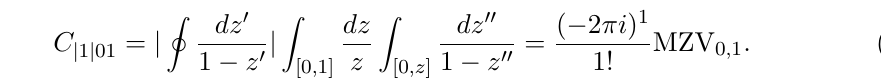
Figure 17 . Contour of integration in the complex z -plane for the calculation of the C The x ’s denote the endpoint z position of the integral R z The integral is evaluated by dividing the contour into parts I, II and III. The remaining section, IV, is the original